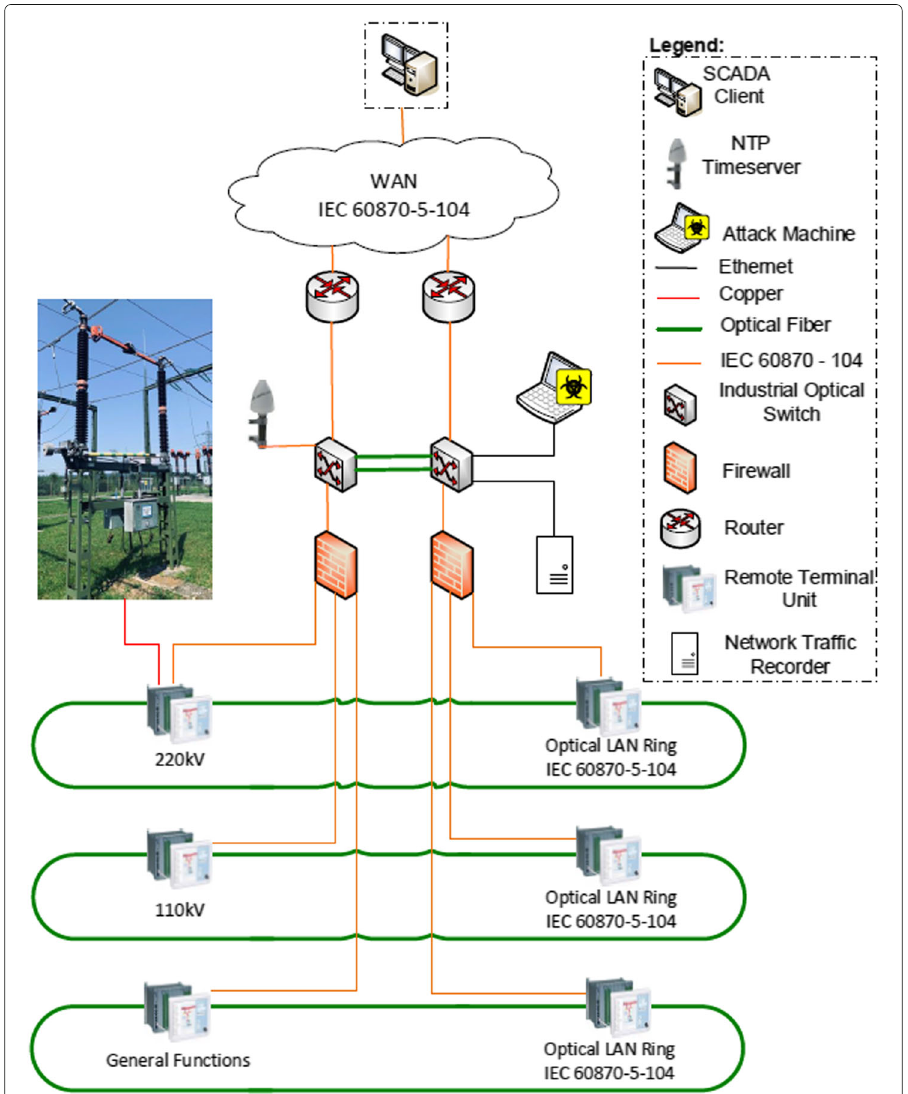
Fig. 2 Network architecture of the test